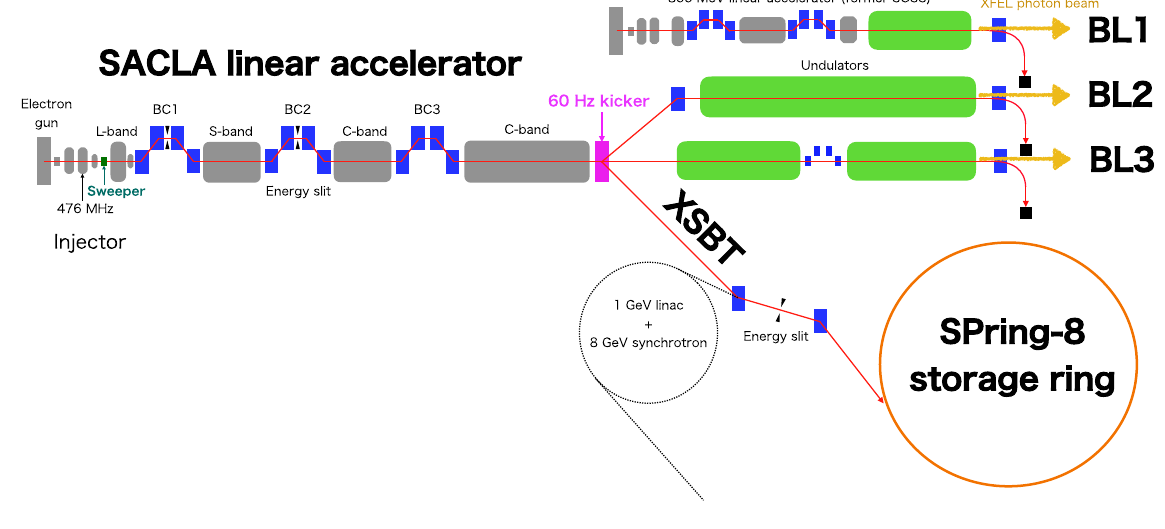
FIG. 2. Schematic layout of SACLA and XSBT.